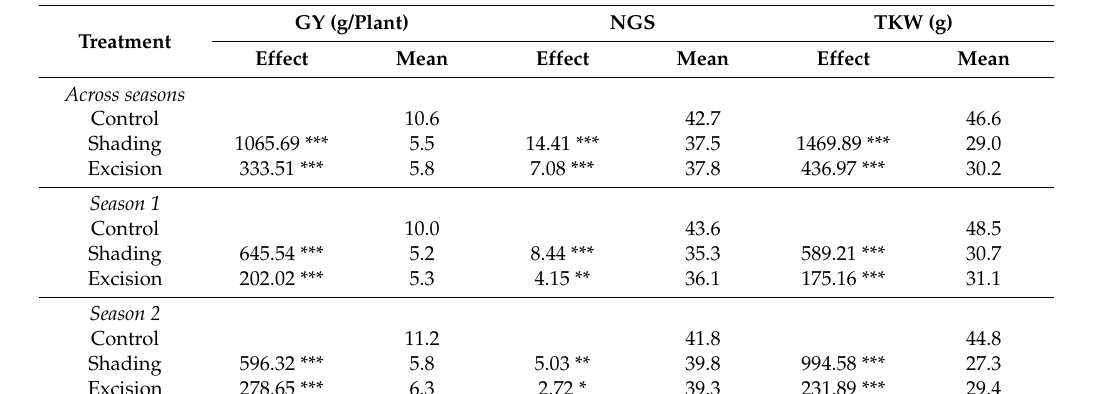
Table 2. Effect of shading and excision treatments on grain yield (GY), number of grain per spike (NGS) and thousand kernels weight (TKW) across the six cultivars, in Seasons 1 and